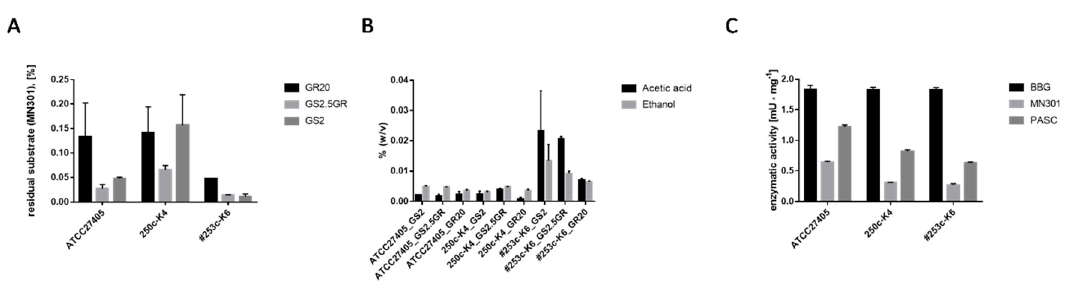
Figure 2. ( A ) Determination of cellulose hydrolysis for three different cultures with H. thermocellum. ( B ) Detection of volatile metabolites from three different cultures with H. thermocellum via gas chromatography. ( C ) Specific activity (mU·mg -1 ) of supernatant proteins on different β -glucans,